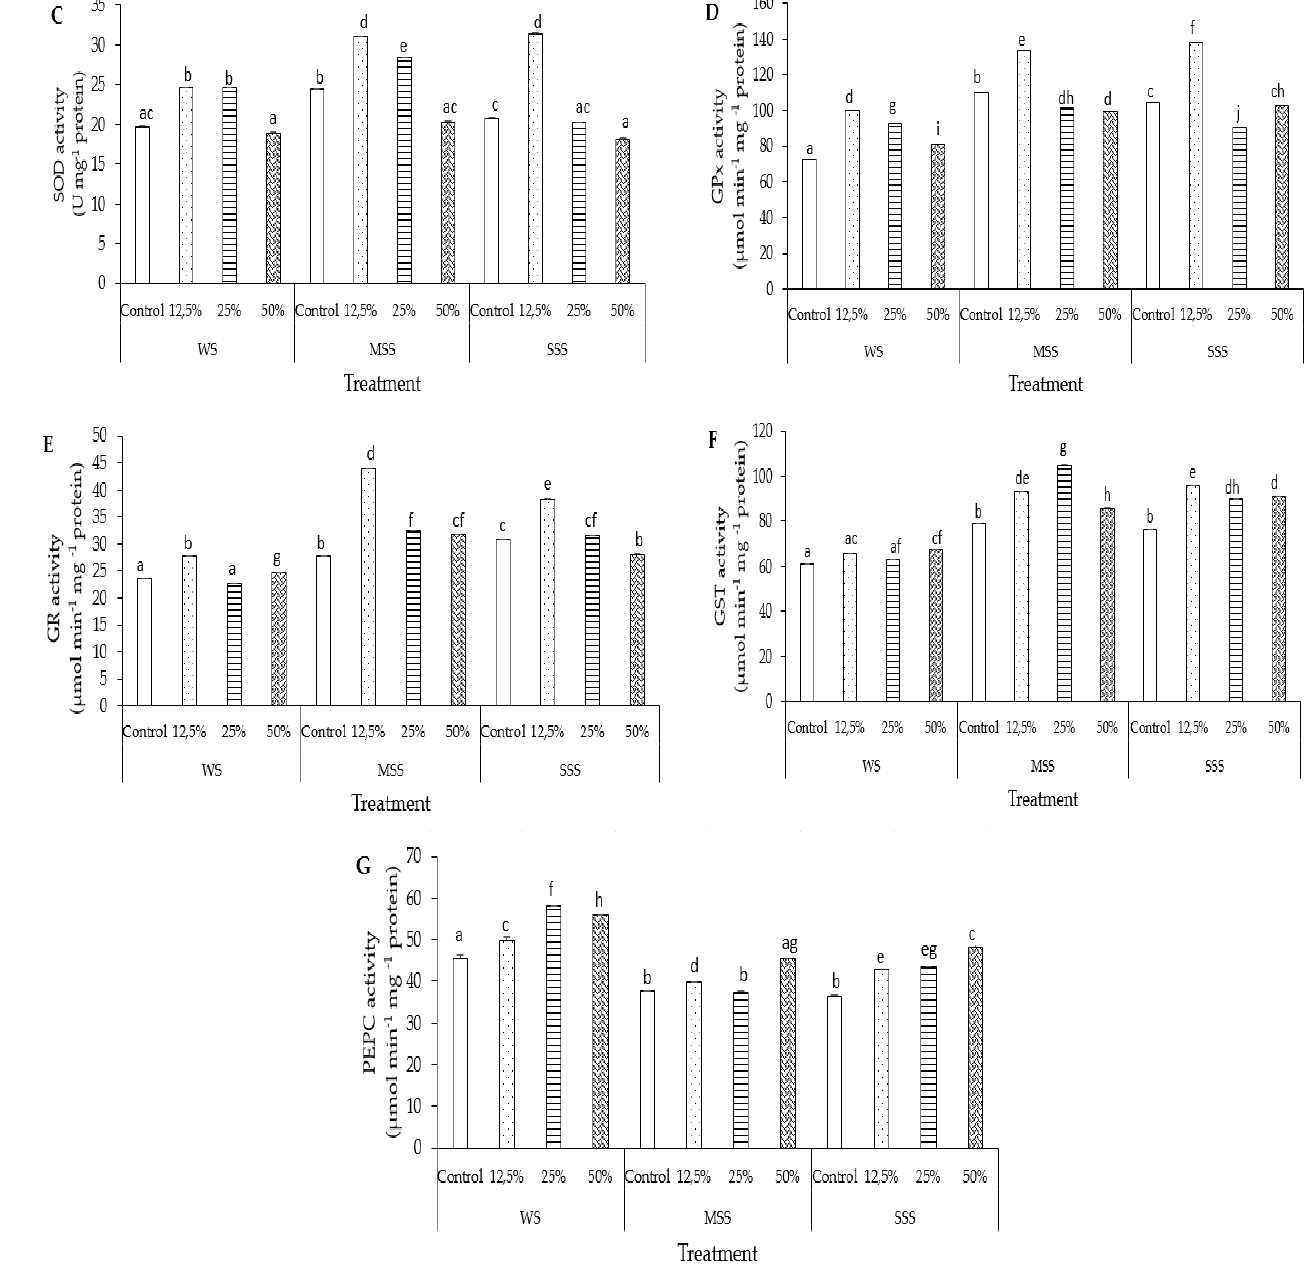
Figure 3. The effect of salt stress on antioxidant enzymes (( A ): ICDH, ( B ): GDH, ( C ): SOD, ( D ): GPx, ( E ): GR, ( F ): GST, ( G ): PEPC. Abbreviations are as follows: WS: Without stress, MSS: Moderate salt stress, SSS: Severe salt stress, %: concentration of Ulva rigida extract in the solution of treatment, Superoxide Dismutase (SOD), Glutathione Reductase (GR), Phosphoenolpyruvate Carboxylase (PEPC), Glutamate Dehydrogenase (GDH), Glutathione Peroxidase (GPx), Glutathione-S-Transferase (GST), and Isocitrate Dehydrogenase (ICDH). Results are means ± S.D. Different letters for each mean show statistically significant differences for p < 0.05